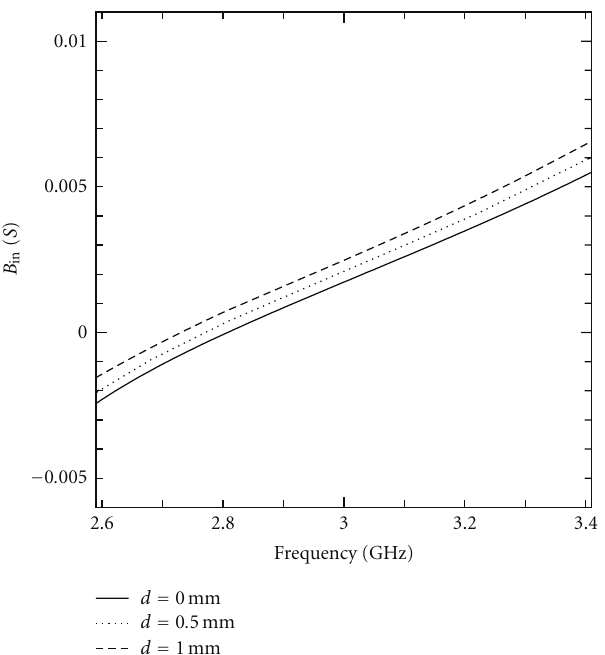
Figure 7: Frequency characteristics of input susceptances of even mode ( a = 5 . 2 mm).